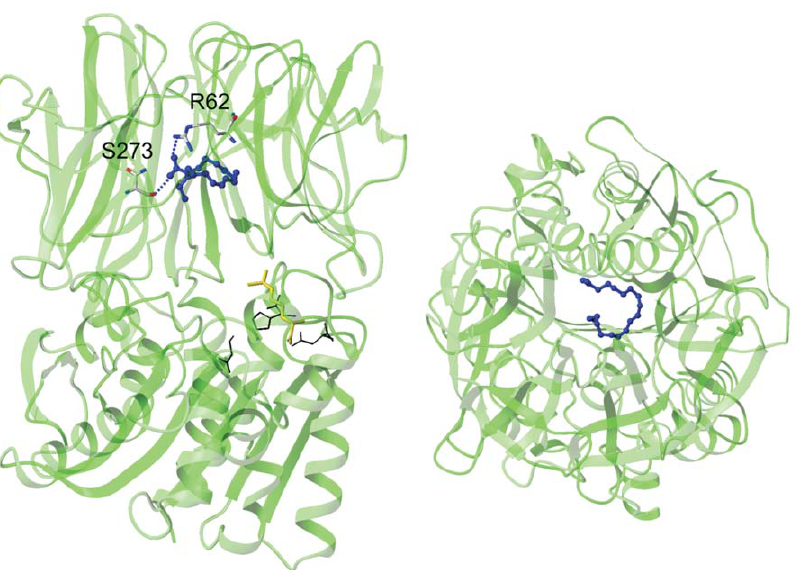
Figure 5. Binding mode of the t 10 c 12 -CLA with APEH Ss . Binding mode suggested by docking analysis for t 10 c 12 -CLA (blue; ball-and-stick mode) with APEH Ss (cartoon representation; green, left). Protein residues involved in stabilising the interactions with the carboxylic group of the t 10 c 12 -CLA are represented as sticks. The Ser-Asp-His catalytic triad residues are shown as black lines; R507 is shown in yellow. (right) View rotated 90 u along the x-axis (the horizontal axis parallel to the image plane).